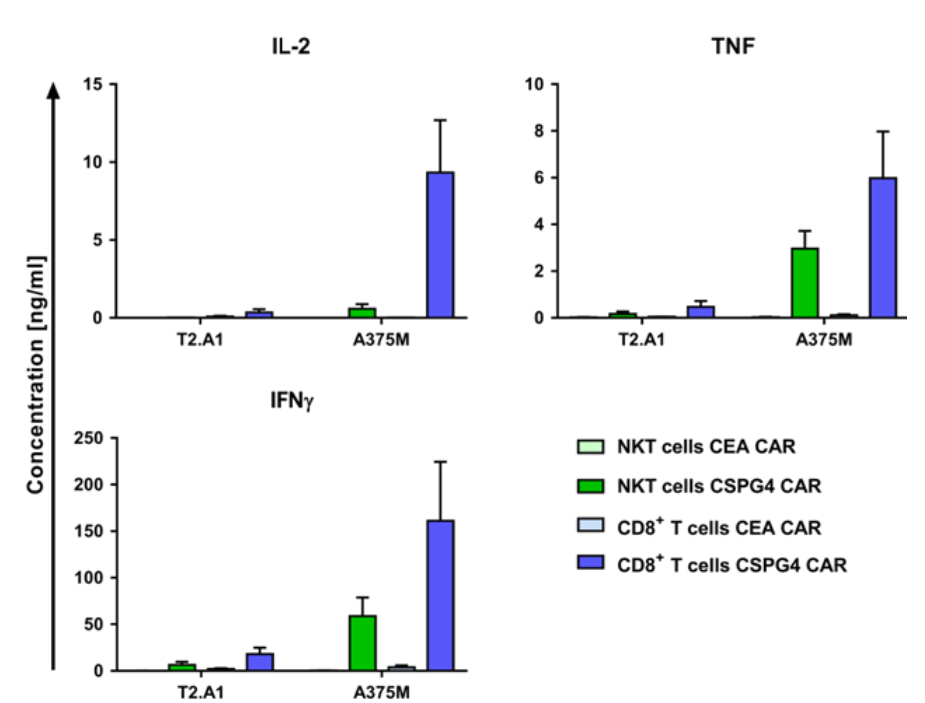
Figure 3. The CSPG4 CAR-transfected NKT cells secrete cytokines in an antigen-specific fashion. The NKT and CD8 + T cells were obtained as described above (see Figure 1). Following 10 – 11 days of expansion, the cells were either electroporated with mRNA coding for a carcinoembryonic antigen (CEA)-specific CAR or with mRNA encoding a CSPG4-specific CAR. The CEA CAR-transfected cells were used as controls. Then, 4 h after electroporation, the cells were co-cultured with target cells overnight. IL-2, tumor necrosis factor (TNF), and interferon-gamma (IFN- γ ) production was measured in a cytometric bead array. As target cells, the TxB cell hybridoma T2.A1 (CSPG4 − , CEA − ) and the A375M melanoma cell line (CSPG4 + , CEA − ) were used. The receptor-transfected NKT cells are shown in light green bars (CEA CAR) and dark green bars (CSPG4 CAR), whereas electroporated the CD8 + T cells are displayed in light blue bars (CEA CAR) and dark blue bars (CSPG4 CAR). The average values of 4 – 7 independent experiments with SEM are shown. The p -values calculated by unpaired Student’s t -test are presented in Tables S6 and S7.